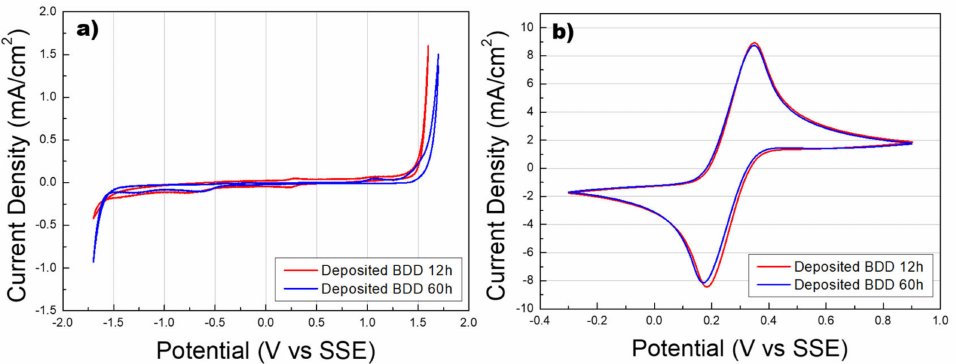
Figure 5. Cyclic voltammetry (CV) curves of BDD films with deposition time in ( a ) 0.5 M Na 2 SO 4 solution and ( b ) mixture of 50 mM K 3 Fe(CN) 6 / K 4 Fe(CN) 6 solution and 0.5 M Na 2 SO 4